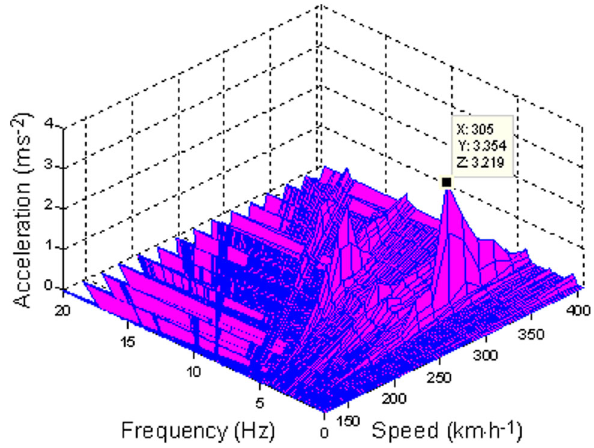
Fig. 11 Spectra of the acceleration responses at the outer rail under various train speeds